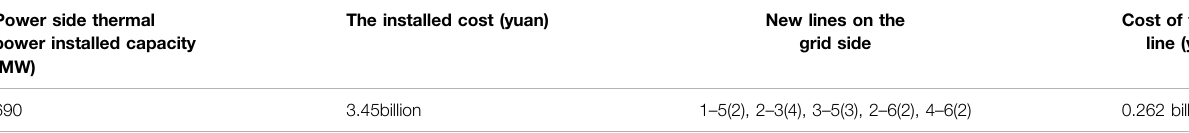
TABLE 2 | Planning scheme of the power grid side without energy storage input.